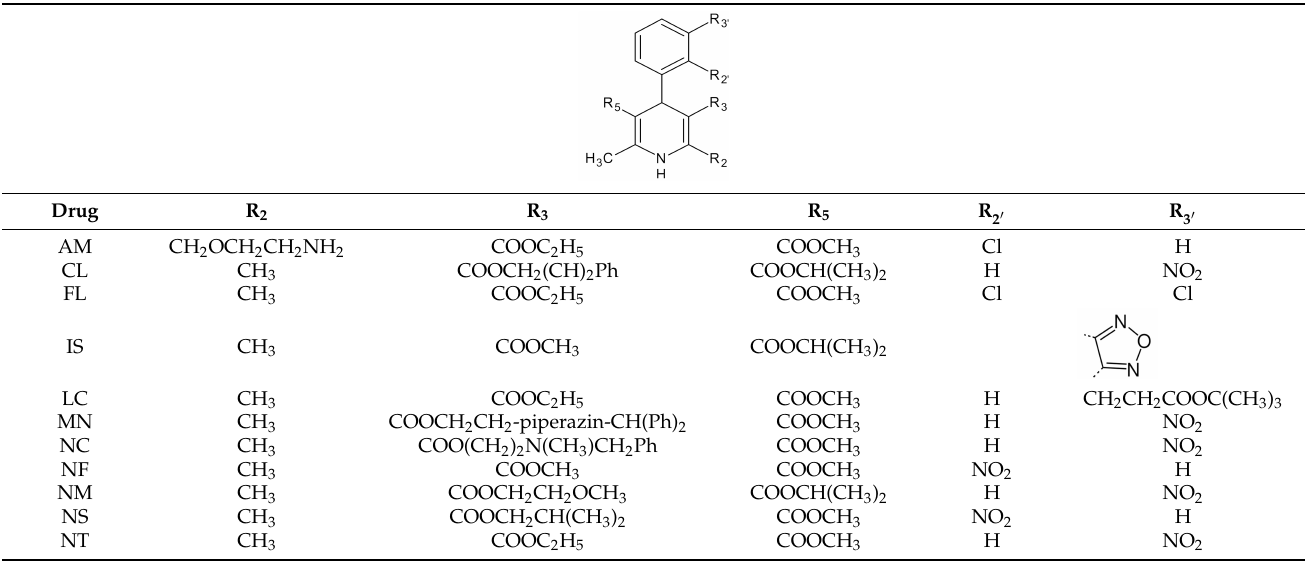
Table 1. DHP chemical